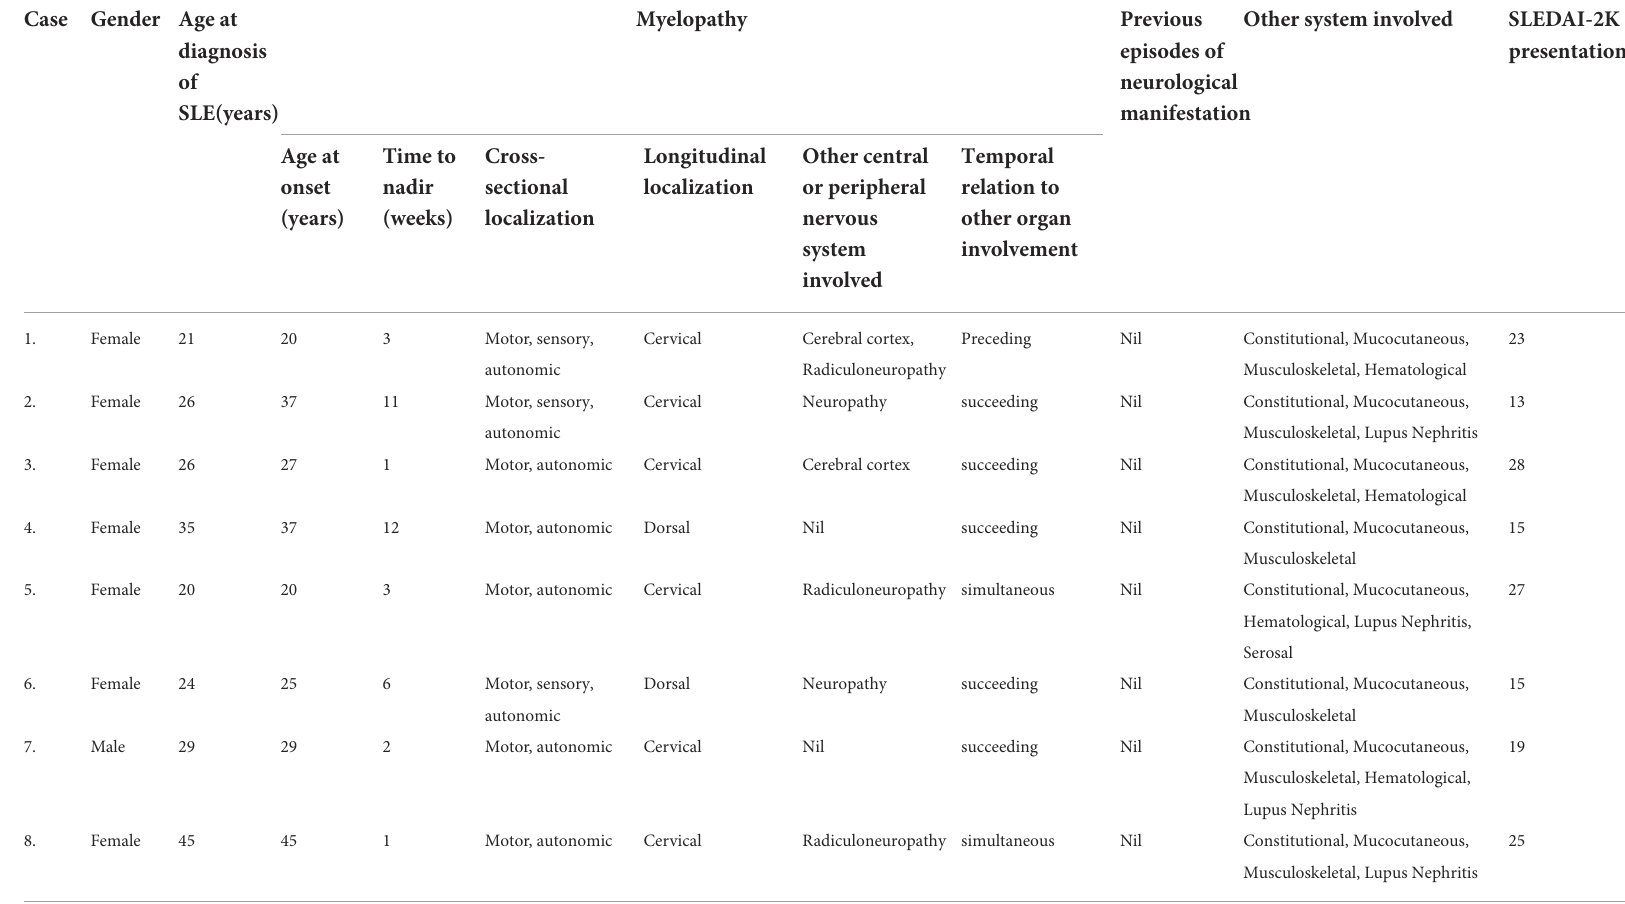
TABLE 1 Clinical features of our cohort of MRI-negative myelitis in